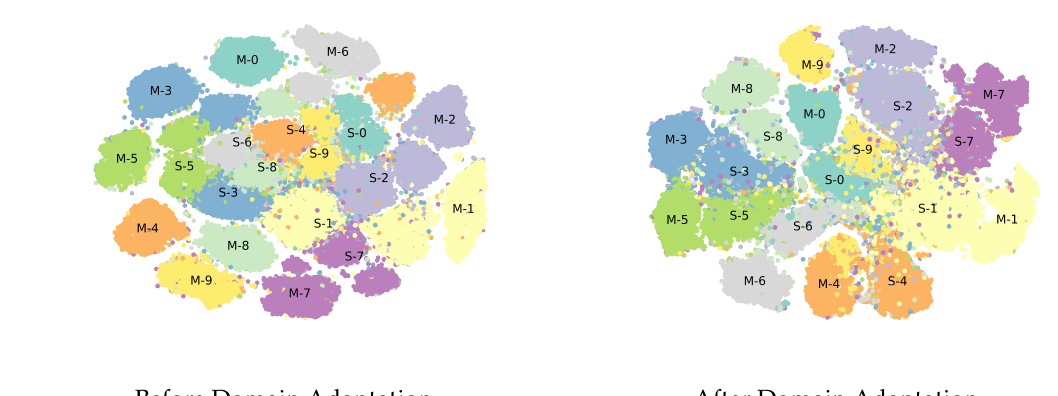
Figure 3. Projection of the latent representations of both source domain (SVHN) and target domain (MNIST), to describe their distribution in the latent space before and after applying our unsupervised domain adaptation method. Each cluster is labeled by M- i or S- i to denote whether it belongs to MNIST or SVHN, respectively; whereas the colors and the i indices represent the labels associated with the